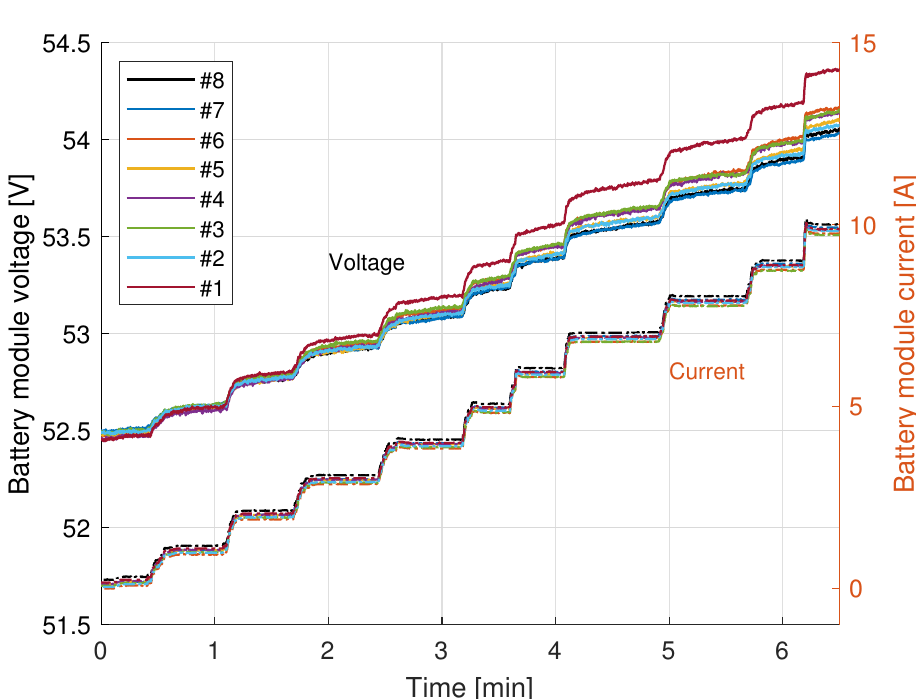
Figure 5. Battery pack in series configuration, charging from a 440V DC source with a stepwise increasing current from 0A to 10A. Voltage at module #1 is raising most.